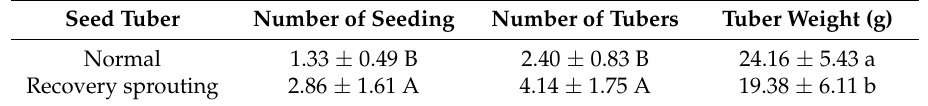
Table 1. Yield comparison per pot of recovery sprout tubers. Seed Tuber Number of Seeding Number of Tubers Tuber Weight (g)